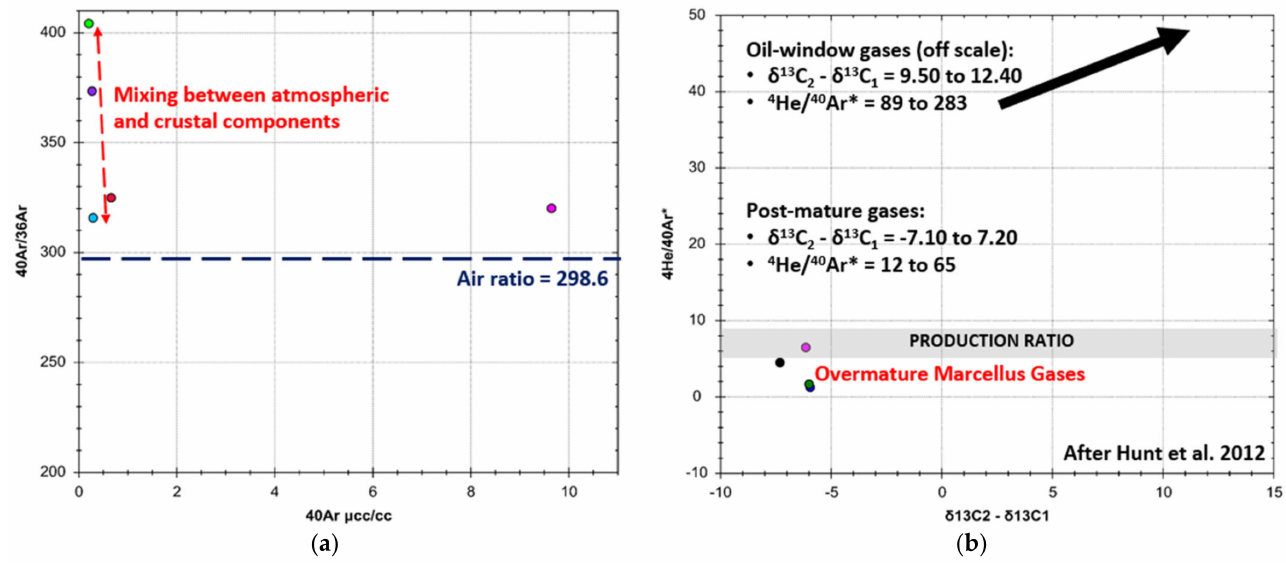
Figure 11. ( a ): 40 Ar concentration versus 40 Ar/ 36 Ar for five selected Marcellus Formation dry produced gases collected in northeastern Pennsylvania (Table 4). ( b ) 4 He/ 40 Ar * versus δ 13 C 2 − δ 13 C 1 for the five selected dry gas samples (after Hunt et al.